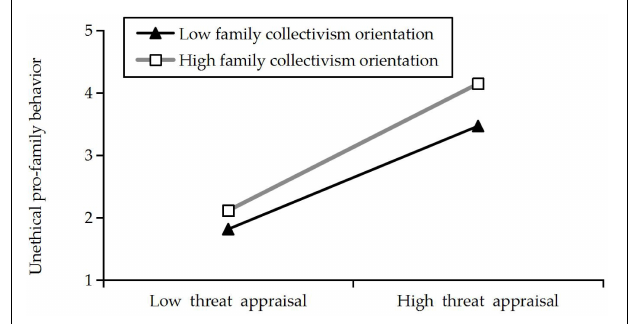
FIGURE 2 | Interactive effect of threat appraisal and family collectivism orientation on unethical pro-family behavior